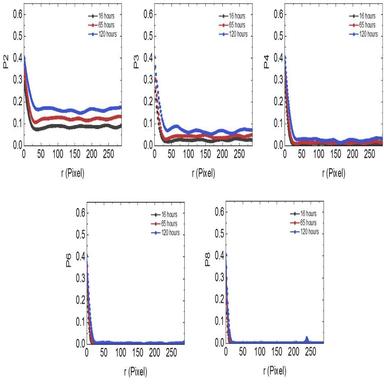
The Pn functions associated with the PbeSn alloy microstructures at different aging times.